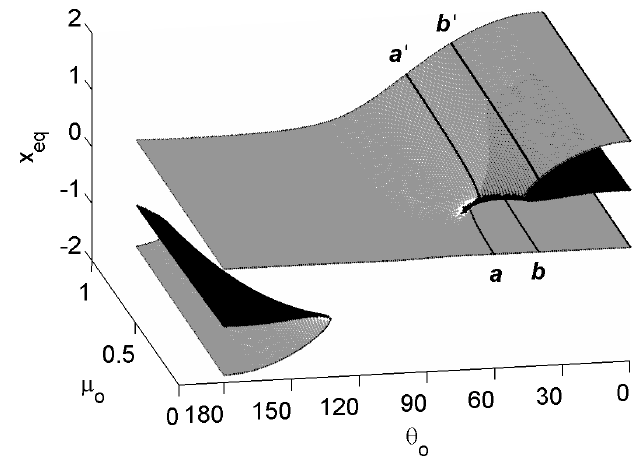
Figure 11. Solution surface of steady-sliding equilibrium at σ = 0.1.